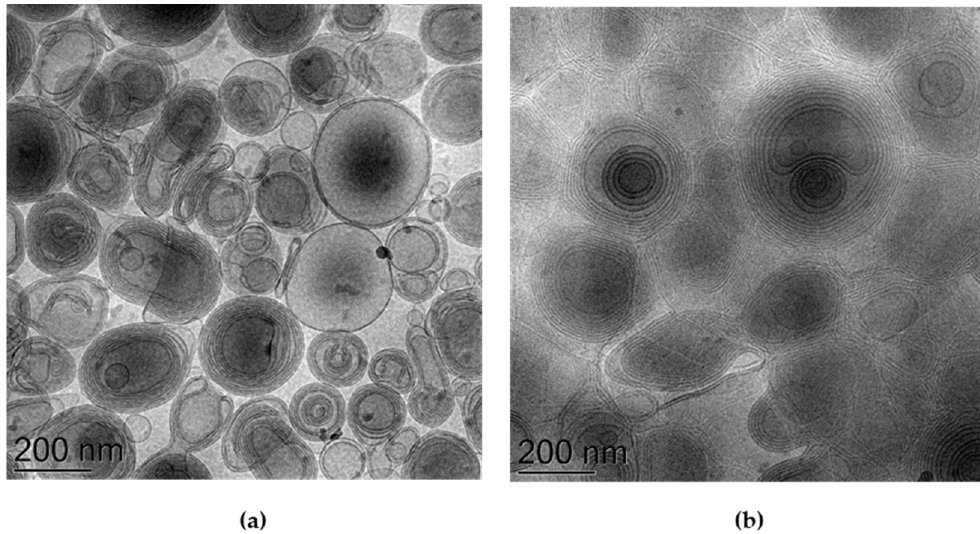
Figure 3. Cryo-transmission electron microscopy images (Cryo-TEM) of E-MG ( a ) and TE5-MG ( b ). Bar corresponds to 200 nm.